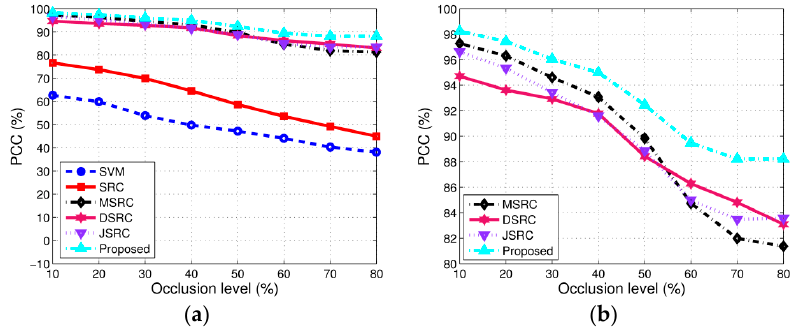
Figure 13. Performance under partial occlusion from direction 5. ( a ) Single view methods; ( b ) Multi-view methods.